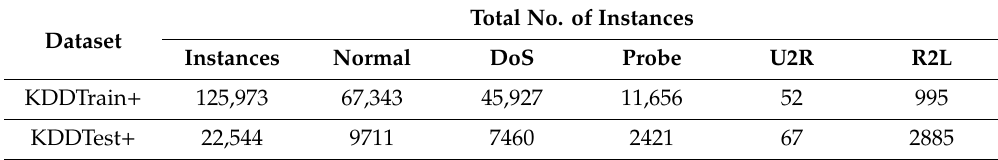
Table 3. Normal and attack instances in the NSL-KDD